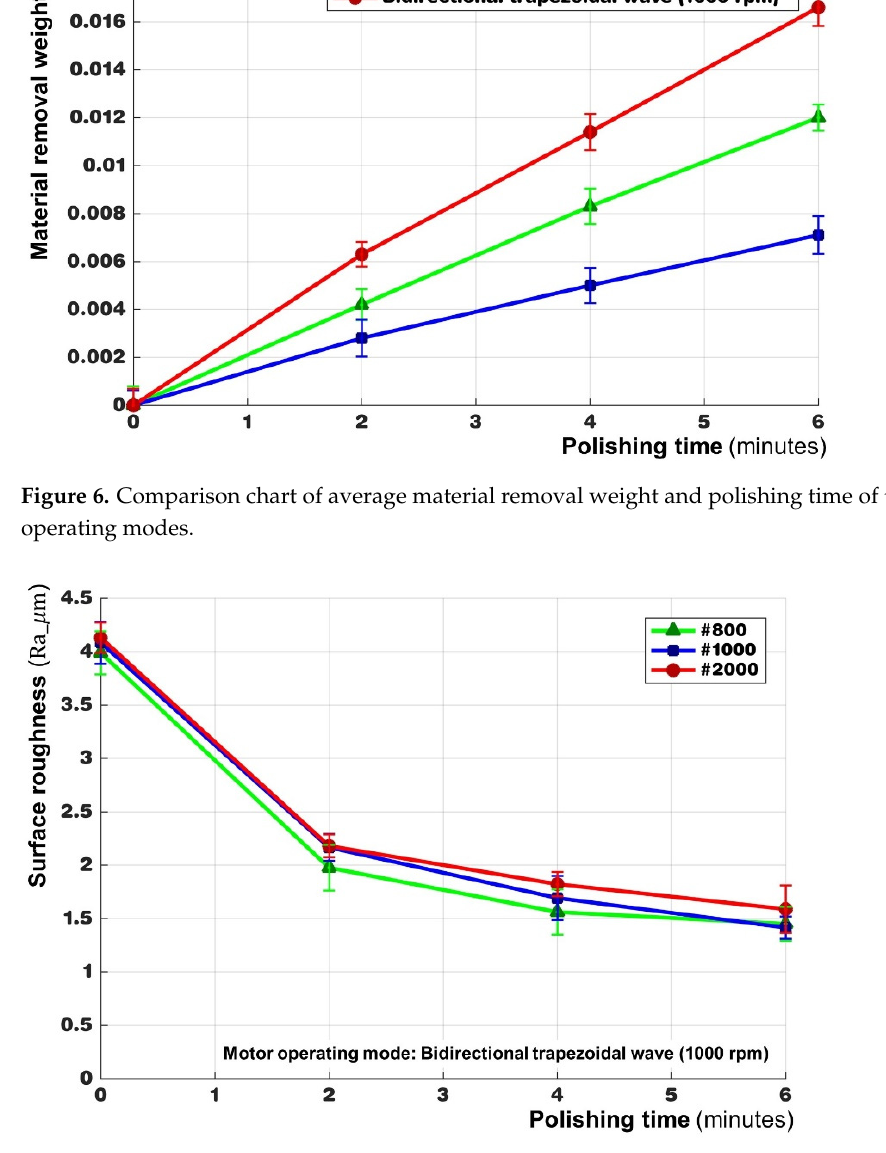
Figure 7. Comparison chart of average surface roughness and polishing time at three motor speeds.